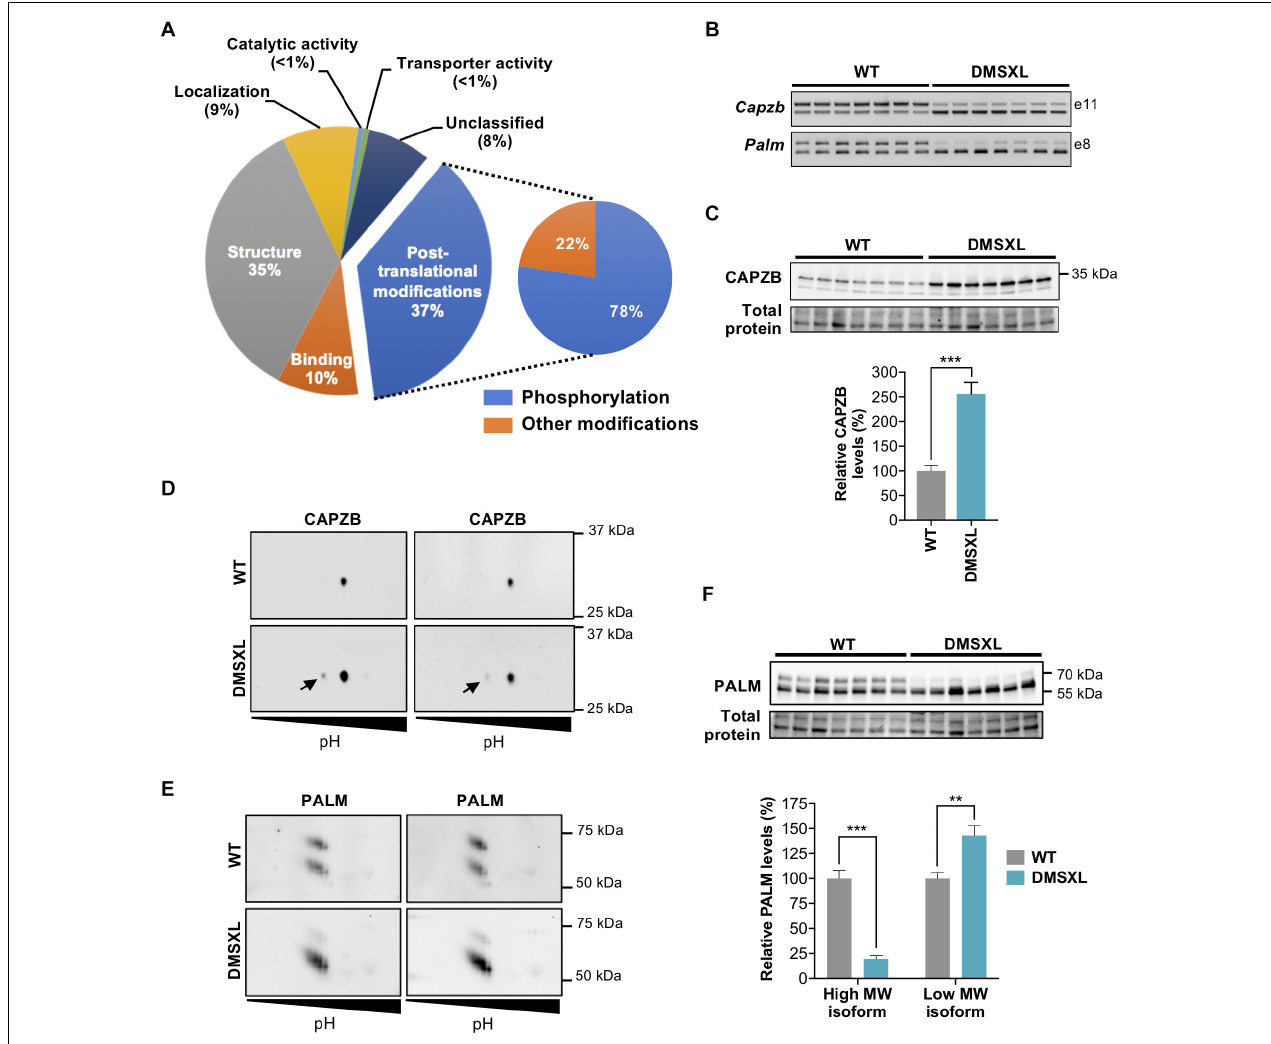
FIGURE 7 | Exon ontology analysis and phosphoproteomic analysis of DMSXL astrocytes. (A) Exon ontology analysis shows the impact of splicing changes on several features of proteins of primary DMSXL astrocytes. (B) Representative RT-PCR analysis of alternative splicing of Capzb exon 11 and Palm exon 8 in primary mouse astrocytes, showing pronounced missplicing in DMSXL cells ( n = 7 independent cultures, per genotype). (C) Western blot analysis of CAPZB, showing upregulation of C-terminal protein isoform in DMSXL astrocytes (*** p < 0.001; Student t -test; n = 7 per group). (D) 2D-WB phosphorylation analysis of CAPZB, showing the expression of a phosphorylated form (arrow) in DMSXL astrocytes ( n = 2 independent cultures, per genotype). (E) Two-dimension western blot of PALM showing abnormal protein isoform between genotypes, revealing low levels of a high molecular weight isoform in DMSXL astrocytes ( n = 2 independent cultures, per genotype). (F) Western blot quantification showing the changes in the relative abundance of PALM protein isoforms: downregulation of the high molecular weight isoform, and upregulation of low molecular weight isoform (** p < 0.01; *** p < 0.001; Mann Whitney U test; n = 7 independent cultures per